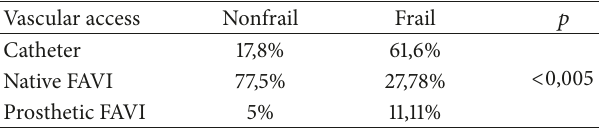
Table 4: Vascular access of frail versus nonfrail